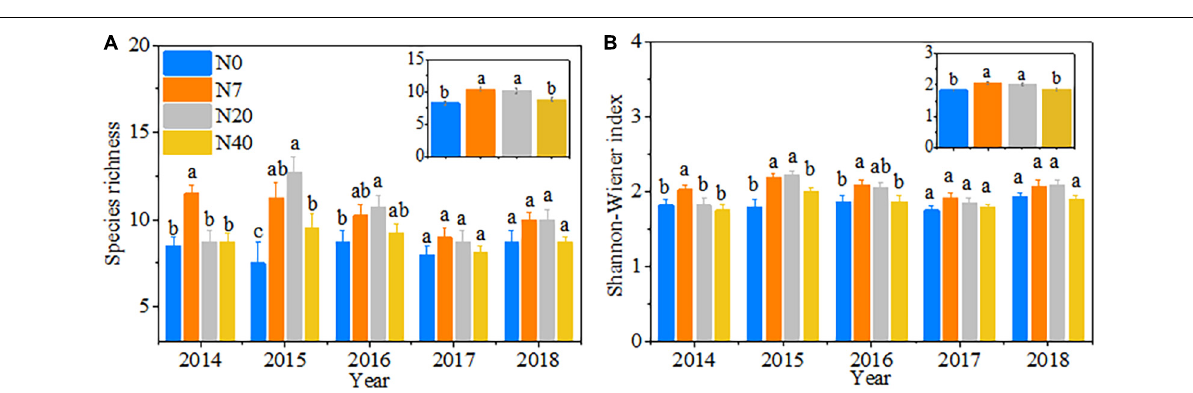
FIGURE 4 | Patterns in (A) species richness and (B) Shannon–Wiener index from 2014 to 2018. The error bars represent the standard error (SE). N0–N40: expressed as control, 0, 7, 20, and 40 N ha − 1 year − 1 . Different lowercase letters indicate significant differences ( p < 0.05) among different N-addition